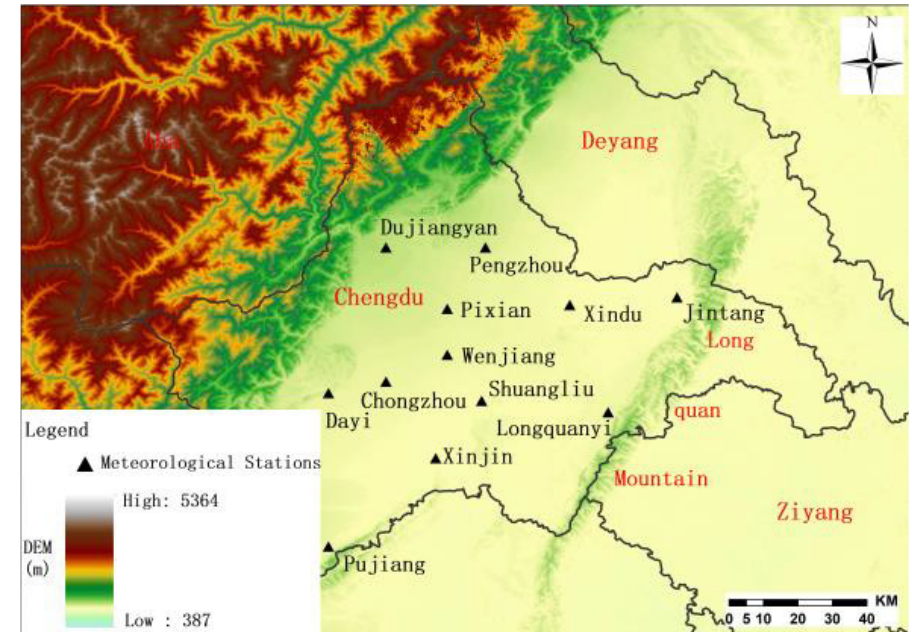
Figure 2. Map of the meteorological stations in Chengdu. Table 1. Statistical benchmarks for the wind speed and temperature.